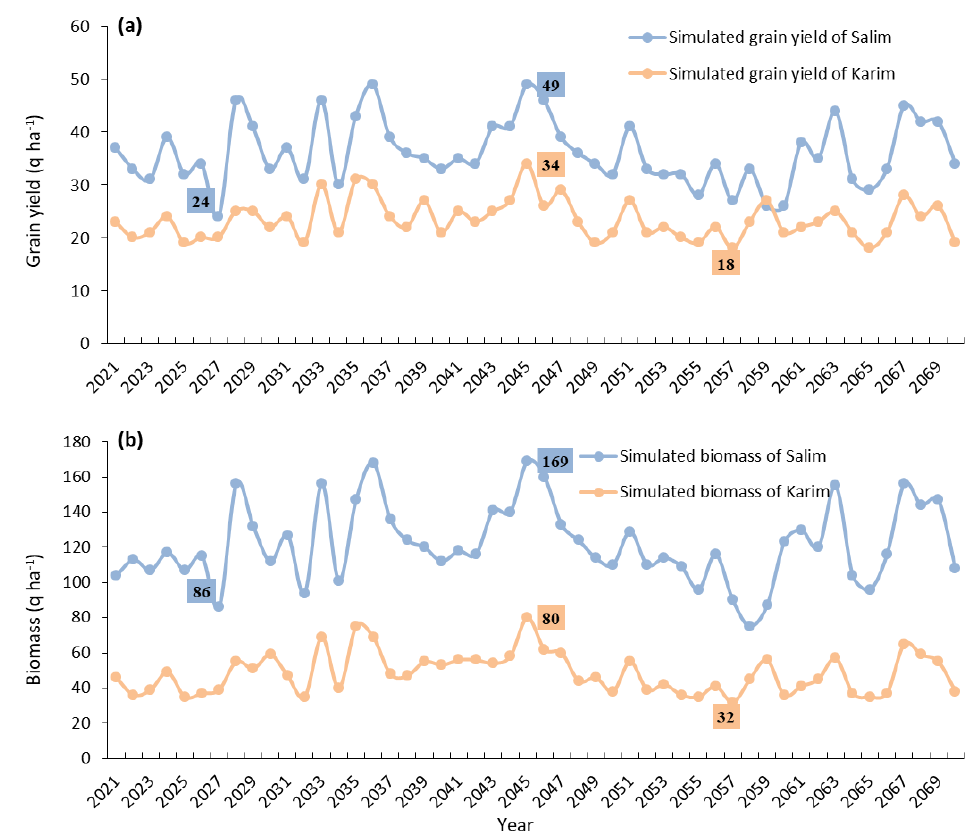
Figure 6. Simulated grain yield ( a ) and biomass ( b ) (2020 – 2070) of ‘ Salim ’ and ‘ Karim ’ cultivars.